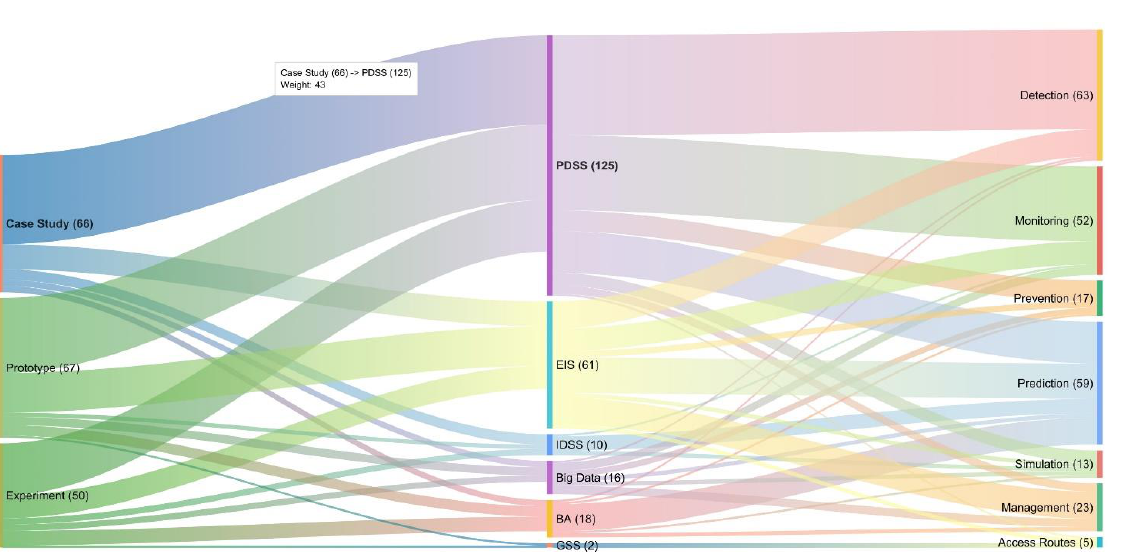
Figure 11. Relationship between the problems encountered and the use of DSS.